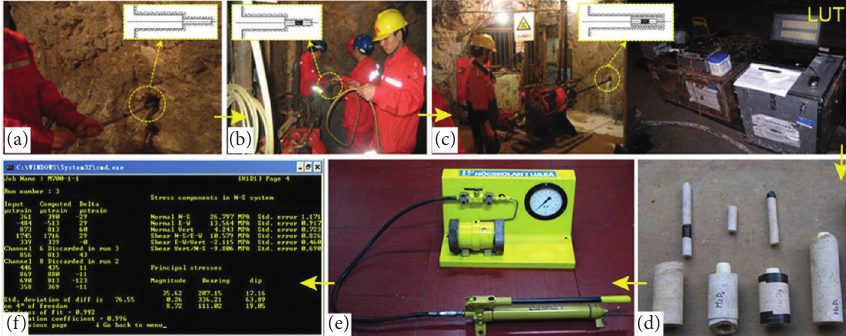
Figure 8: Stress relief process. (a) Drilling and cleaning, (b) installing strain gauge probe, (c) stress relief and data acquisition, (d) getting the core tube, (e) confining pressure calibration, (f) and in situ stress